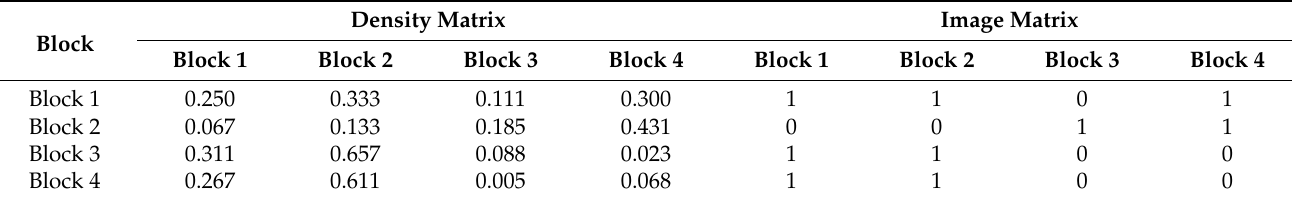
Table 6. Density matrix and image matrix of the spatial correlation block of tourism eco-efficiency in the Yangtze River Delta.